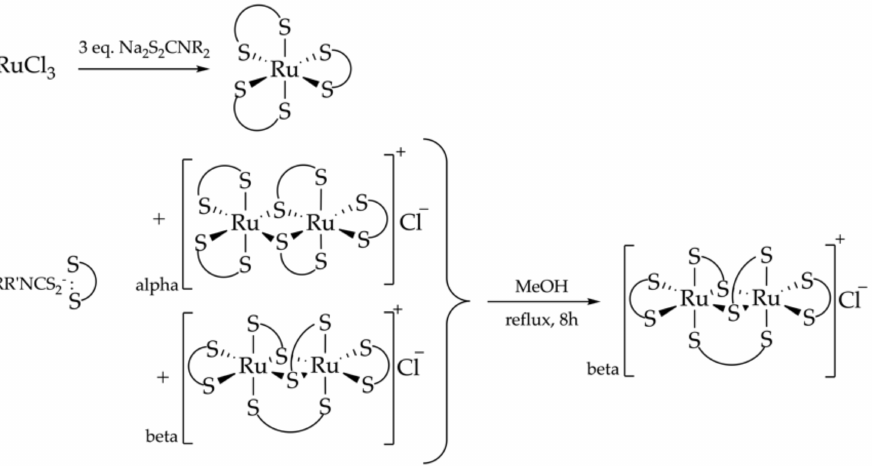
Figure 1. Reaction scheme for the synthesis of homoleptic binuclear dithiocarbamate complexes of Ru(III) via the addition of a dithiocarbamate salt to RuCl 3